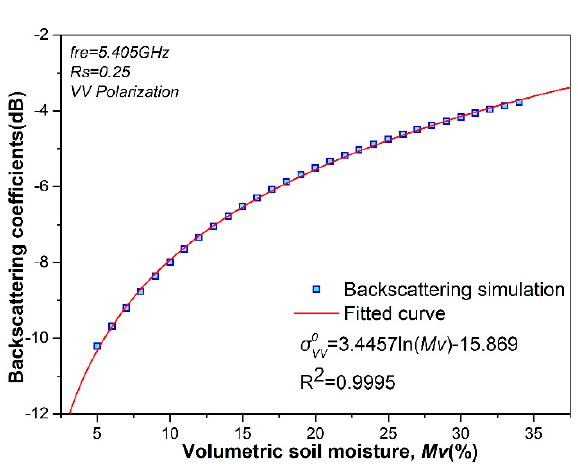
Figure 6. Backscattering coefficient (dB) simulation in the VV polarization at 30° incidence with 0.25 R s , presented using blue blocks. The red line represents the fitted curve.